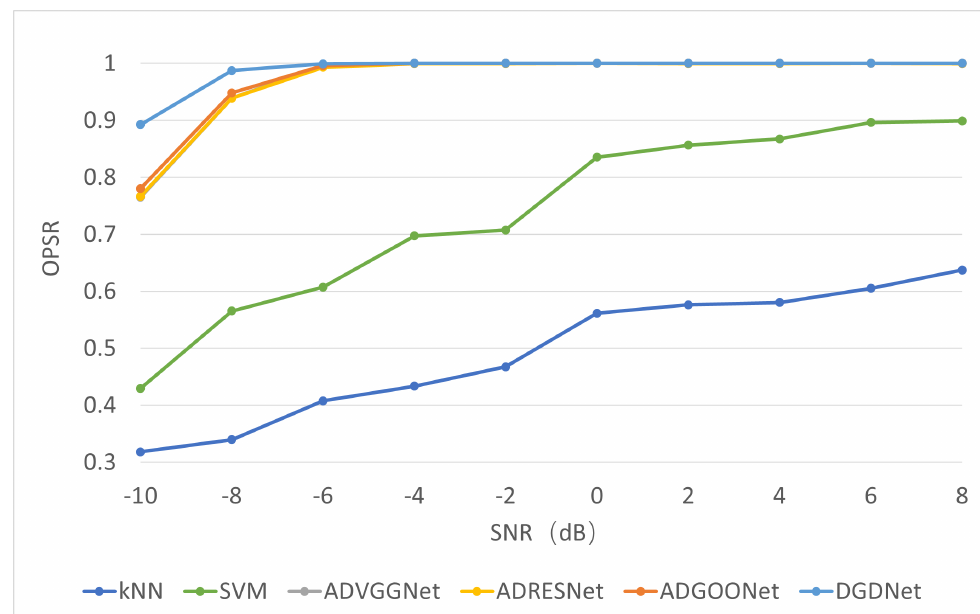
Figure 8. Comparison with the CDAE-DCNN in [6]. Among them, classical machine learning algorithms such as SVM and kNN have unsatisfactory accuracy, while deep-learning-based methods are more competitive in accuracy regardless of low SNR or high SNR.